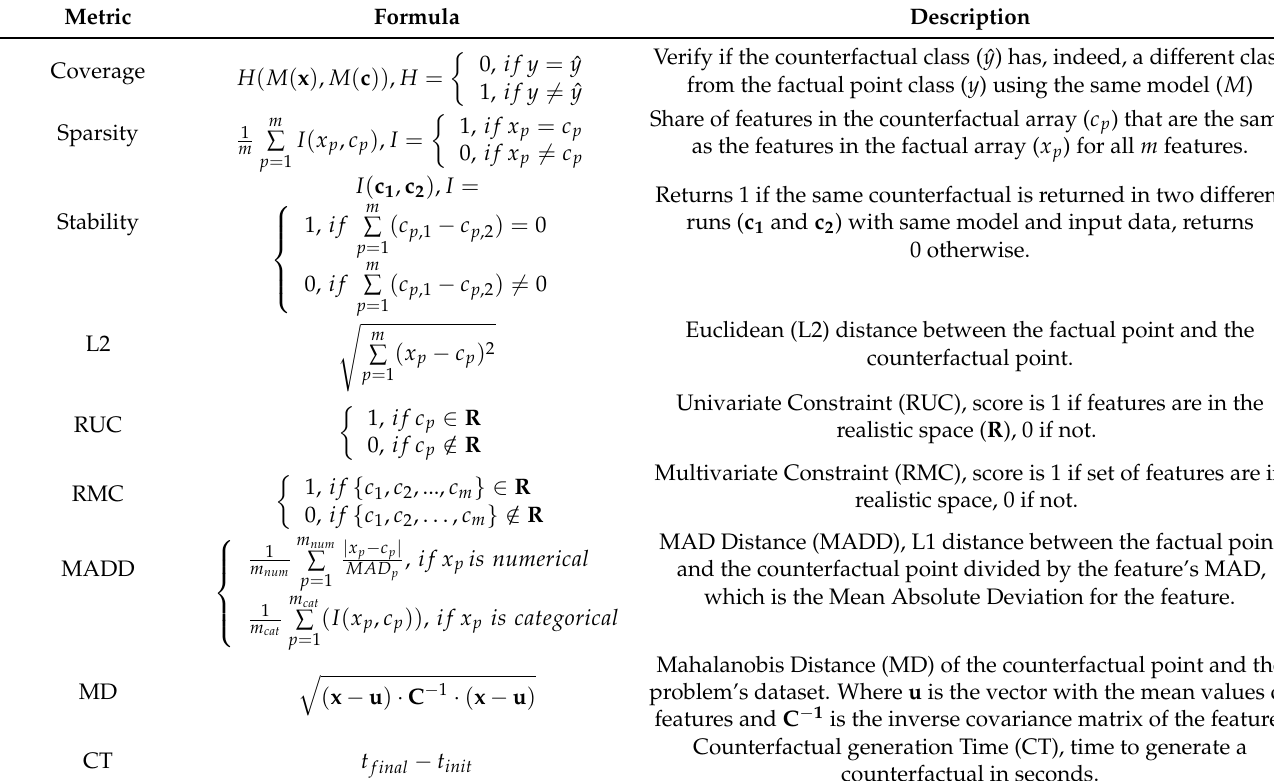
Table 3. Metrics used in the study with their respective descriptions.